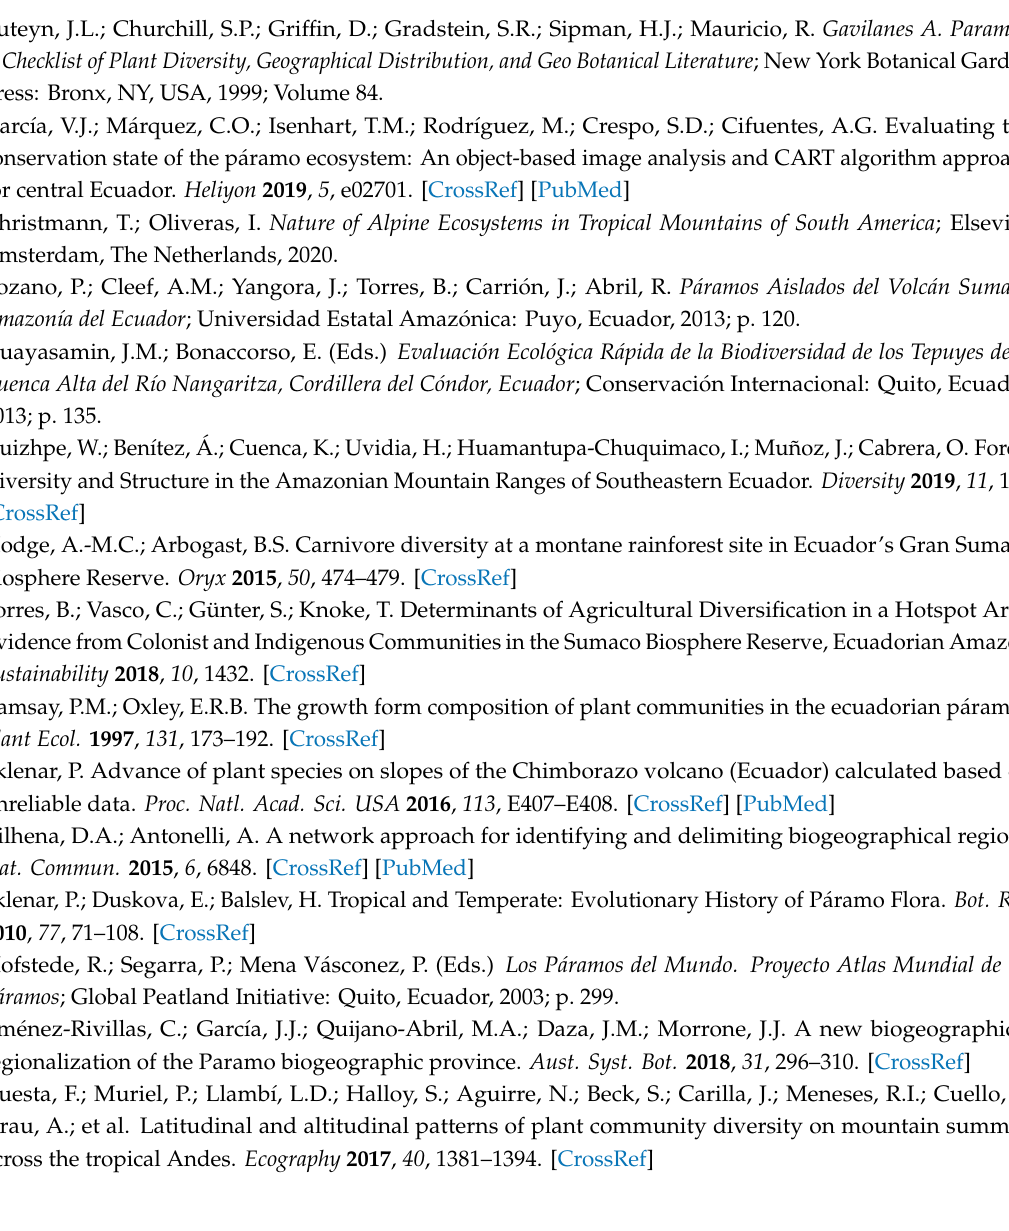
Table S1: Field data (excel